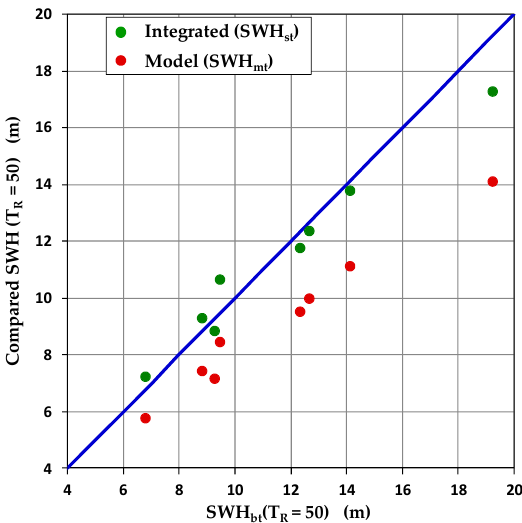
Figure 6. Gulf of Mexico error analysis for T R = 50 years: SWH(T R ) values computed through model data (red circles) and integrated procedure (green circles) are compared with SWH(T R ) values computed through buoy data (solid blue line). R 2 between SWH st and the identity line 0.925.